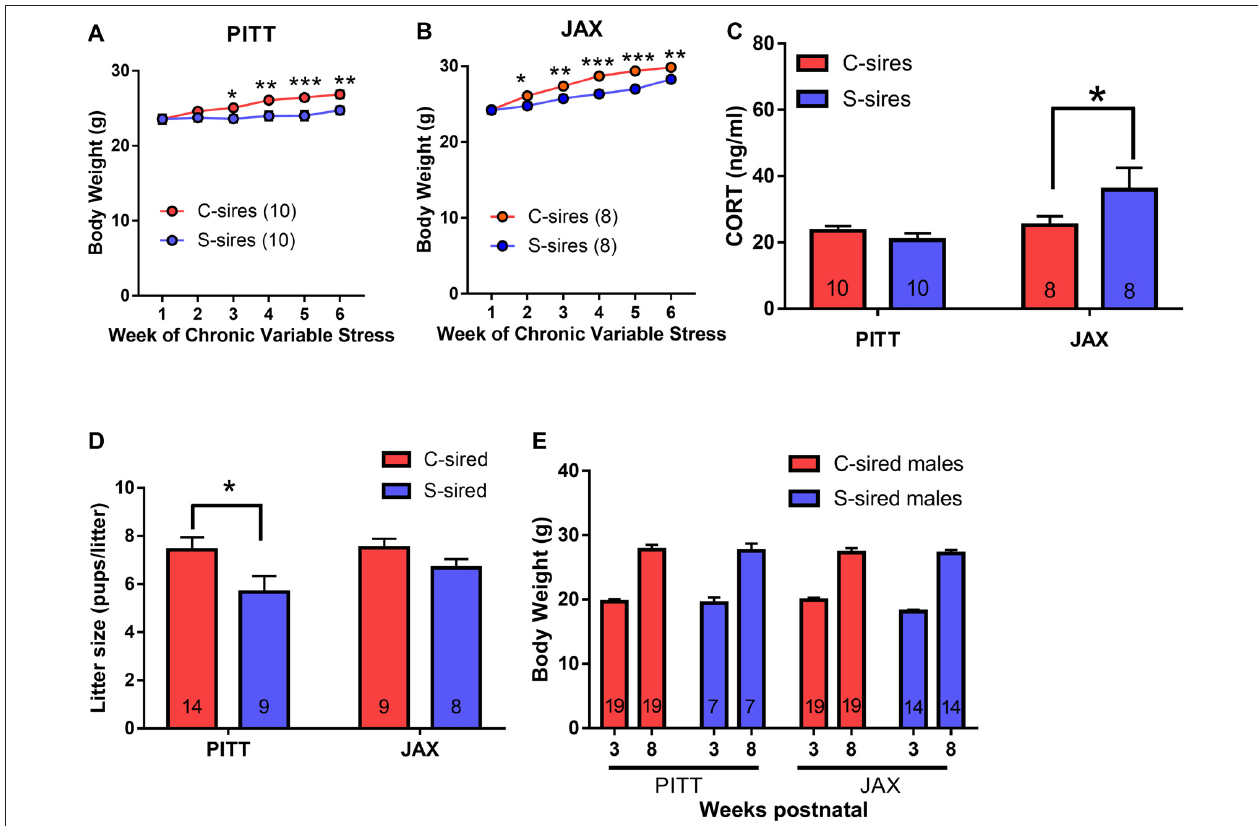
FIGURE 8 | Comparing the effects of stress on in-house colony (PITT) vs. JAX-shipped sires. (A) Stress significantly reduced sire body weights in PITT and (B) JAX sires ( N = 8–10/group). (C) Significant increase in basal CORT levels in JAX S-sires compared C-sires ( N = 8–10/group). (D) Significant effect of paternal stress on litter sizes ( N = 8–14/group). (E) No effect of paternal stress on body weights at three and 8 weeks postnatal ( N = 7–19/group). ∗ p < 0.05, ∗∗ p < 0.01, ∗∗∗ p < 0.001. Error bars are obscured by data points in panels (A,B)